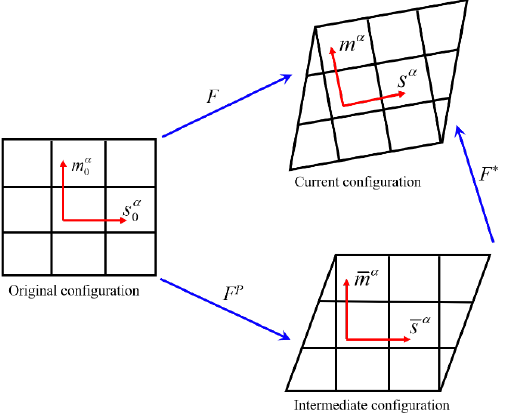
Figure 4. Schematic diagram of the multiplicative decomposition of the deformation gradient.